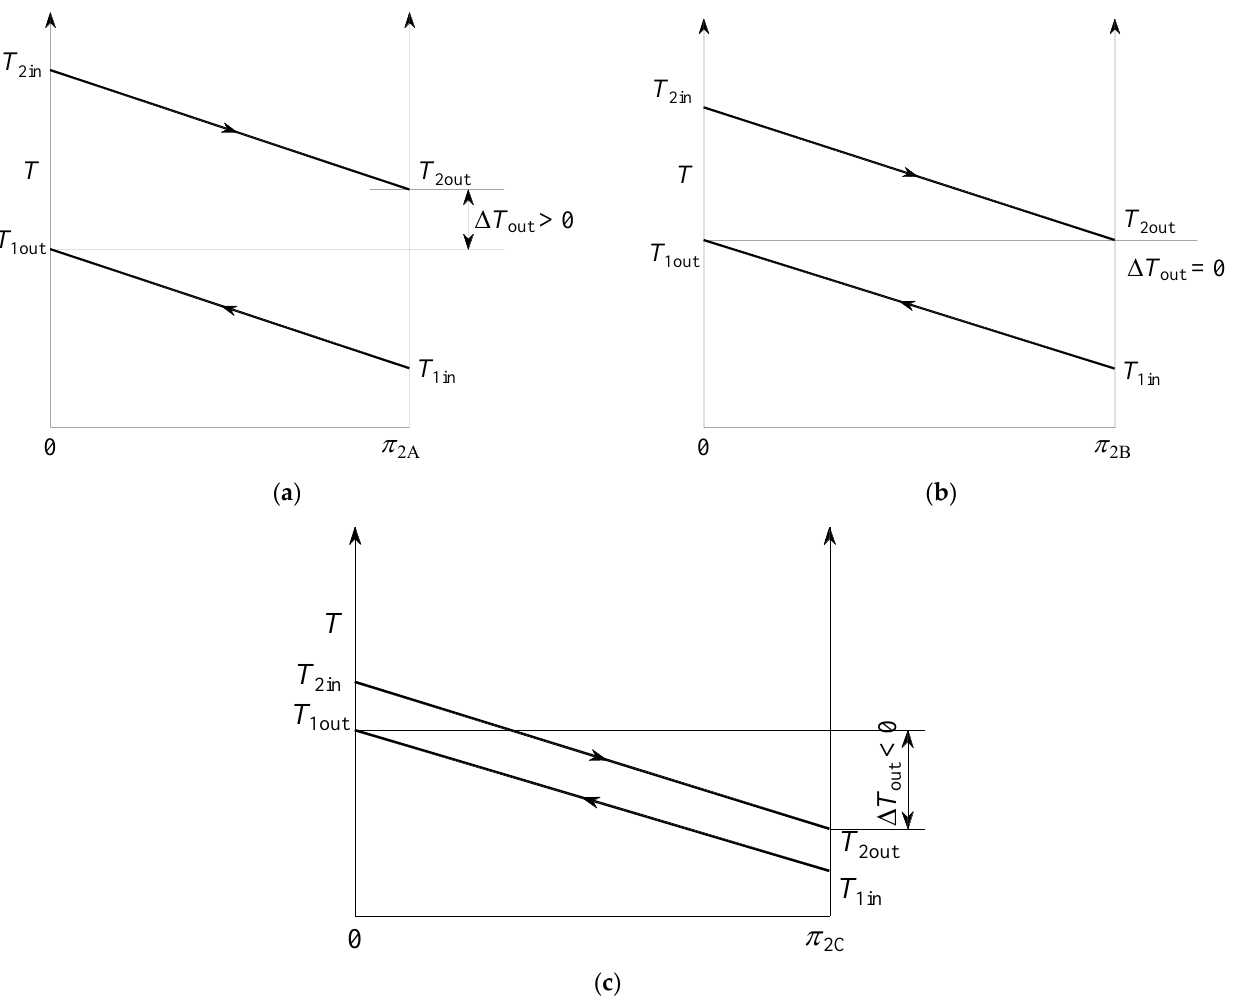
Figure 2. Characteristic π 2 values and temperature streams in the balanced counter-flow recuperators A, B and C: ( a ) ∆ T out > 0. ( b ) ∆ T out = 0. ( c ) ∆ T out <